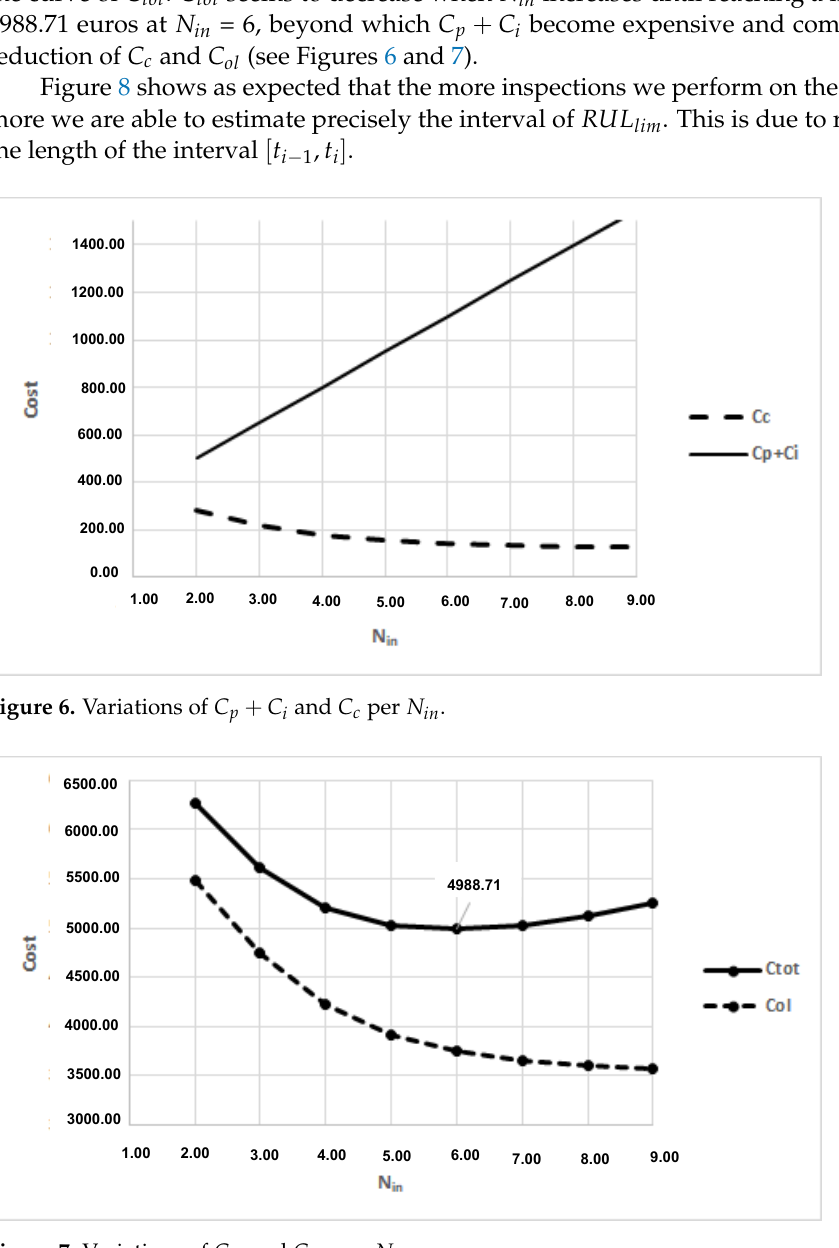
Figure 7. Variations of C ol and C tot per N in